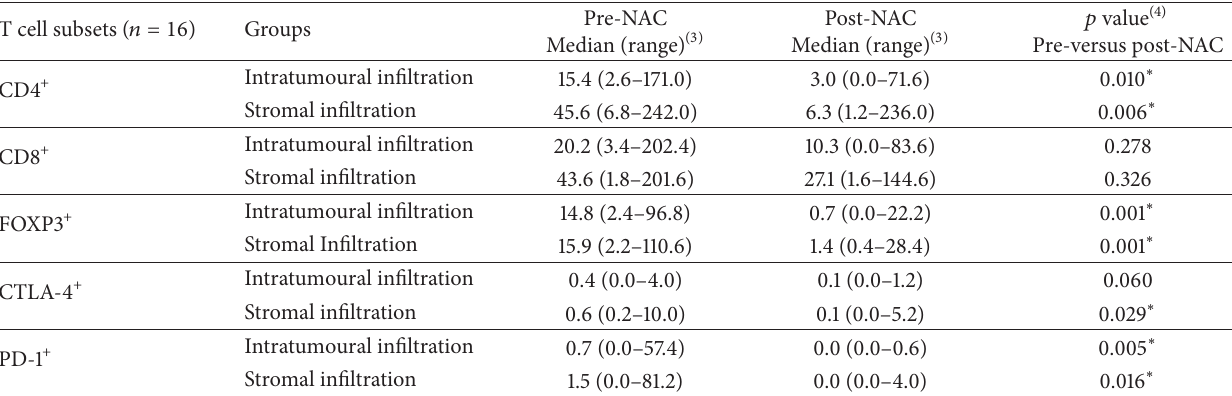
Table 5: T cell subsets infiltrating tumours (intratumoural, stromal) in women with LLABCs (1) : significant reduction with NAC (2) . T cell subsets ( 𝑛 = 16 )